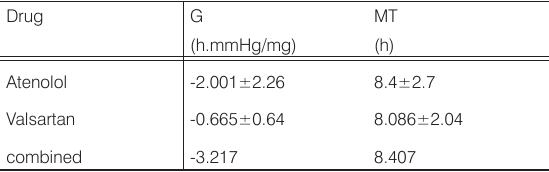
G and MT- gain and mean time of SP effect; ±–standard deviation.